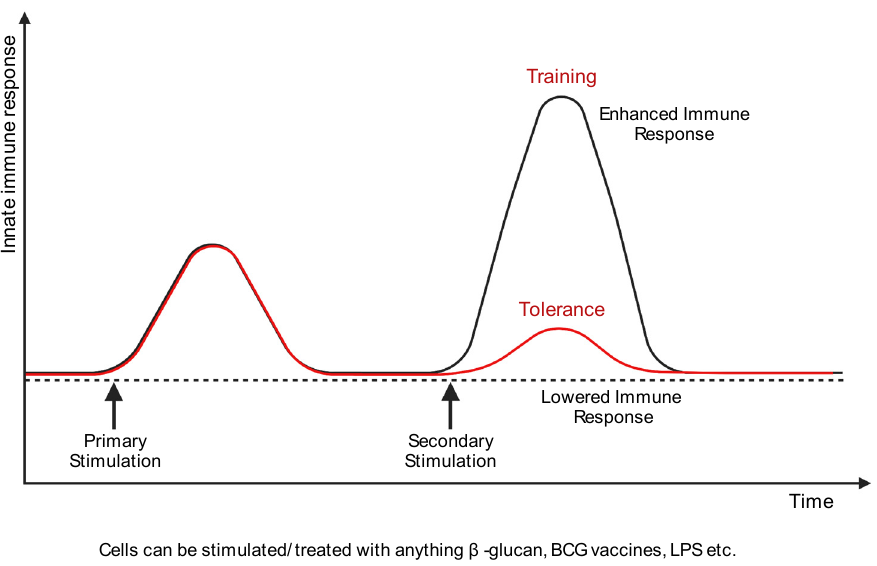
Figure 2. Macrophage training and tolerance. Training of macrophages (black line) is a higher and quicker secondary response upon subsequent stimulation. However, macrophage tolerance (red line) is the attenuated gene expression in response to secondary stimulation. Created with BioRen- der.com